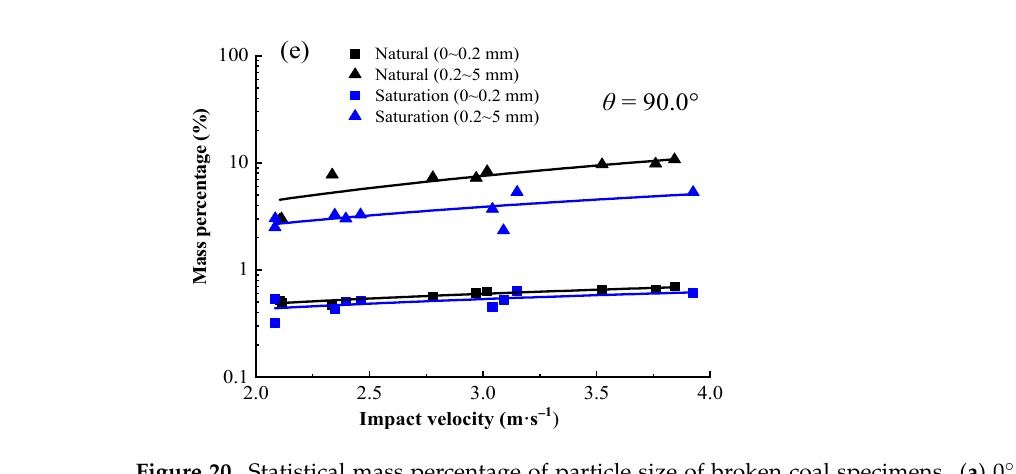
Figure 21. Schematic diagram of CDEM method and principle. ( a ) The structure of the numerical model in CDEM. ( b ) Node type in CDEM. ( c ) The element of finite element in CDEM. CDEM can monitor the contact force, the type of microcracks and the number of mi ‐ crocracks at various points within the specimen during the test, while the development of cracks on the surface of the specimen and the displacement of the specimen as a whole can be observed on a macroscopic level. In CDEM, when the particles are subjected to an external load, the particles move and change the bonding force between them. When the bonding force exceeds the bonding strength of the particles, microscopic cracks are cre ‐ ated, and adjacent cracks overlap to form macroscopic visible cracks.